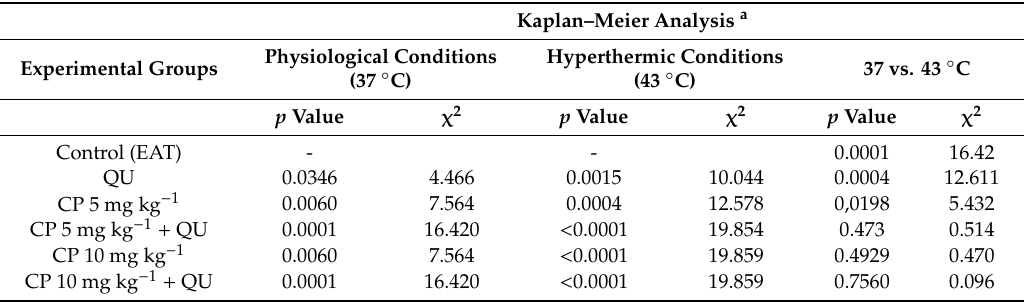
Table 4. Kaplan–Meier survival analysis of Swiss albino mice bearing EAT tumor after treatment under physiological and hyperthermic